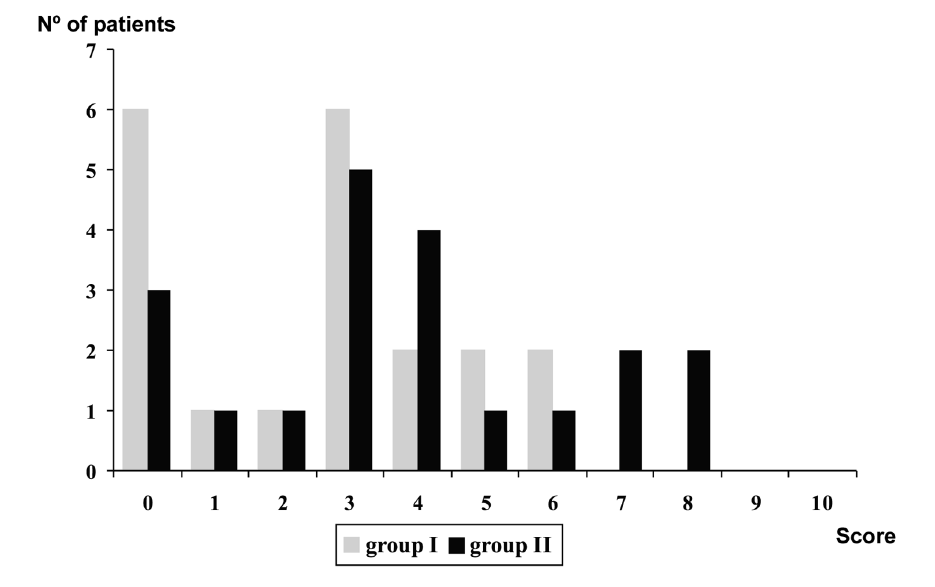
Figure 3 – Individual score for pain in groups I and